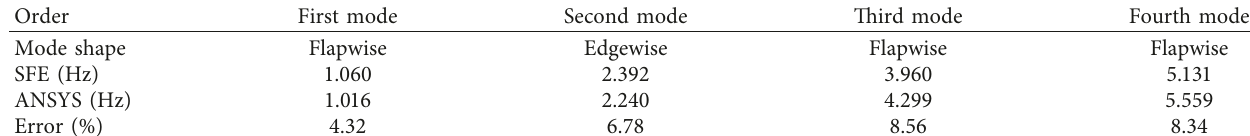
Table 2: Comparison of modal frequencies of the tapered wind turbine blade.